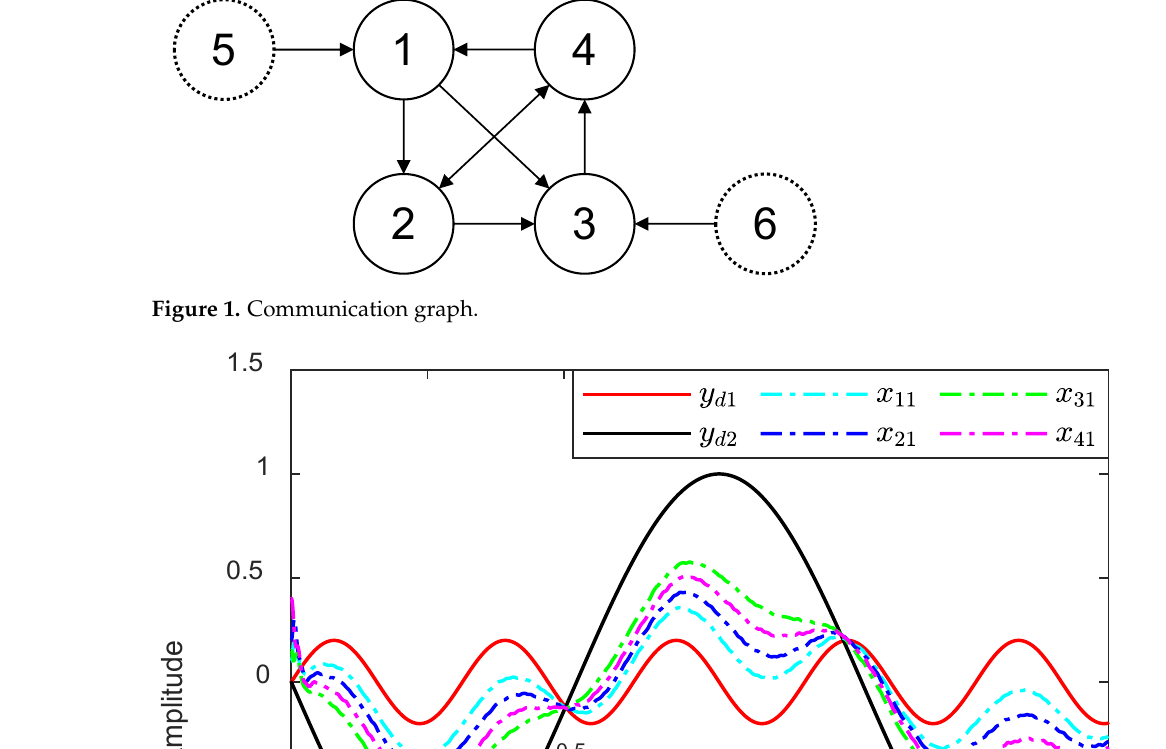
, y d and x i ,1 ( i = 1, · · · ,4 ) 1 2